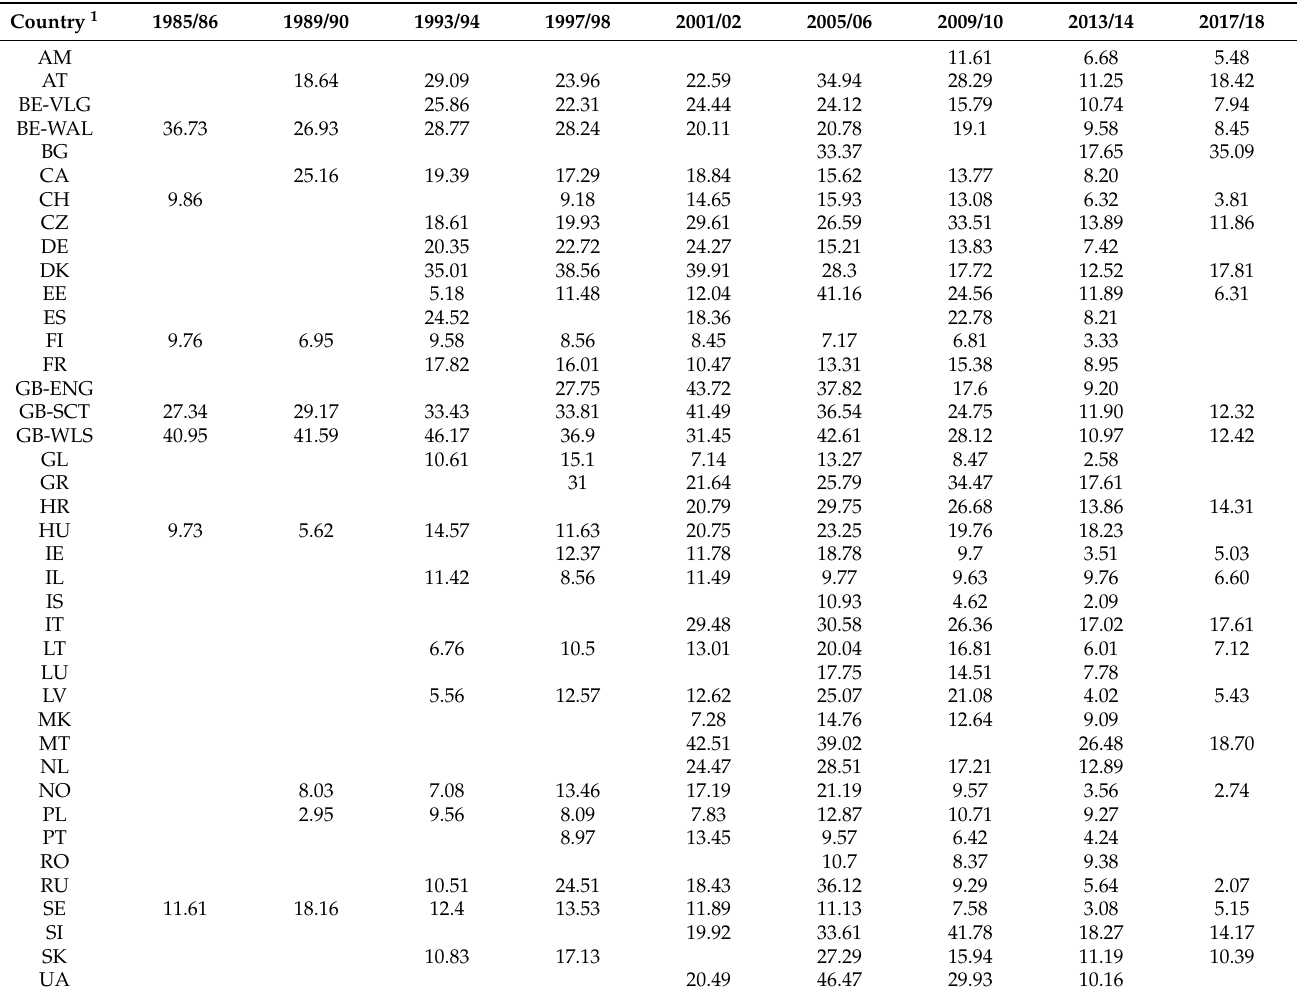
Table 2. Prevalence (%) of weekly/daily alcohol consumption by country and wave from 1985/86 to 2017/18 among